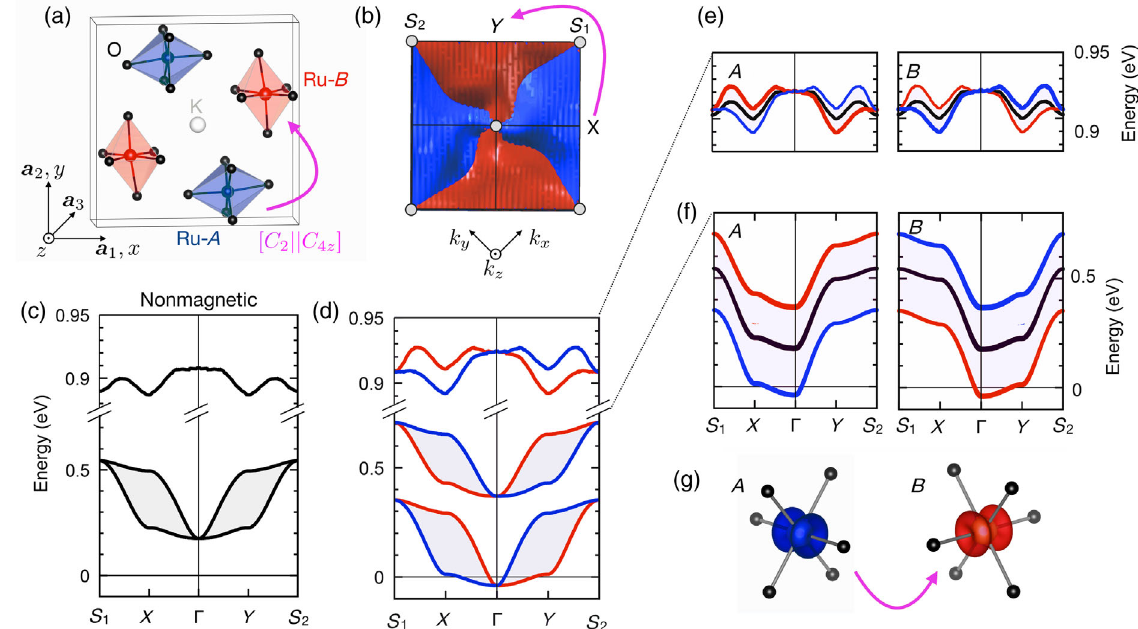
FIG. 3. Spin splitting by the electric crystal potential in KRu 4 O 8 in the third magnetic phase. (a) Schematic spin arrangement on the KRu 4 O 8 crystal with opposite-spin directions depicted by red and blue color. Magenta arrow and its label highlights the opposite-spin- sublattice transformation containing a real-space fourfold rotation. (b) Calculated spin-momentum locking with the characteristic spin- group integer 2 on top of two DFT Fermi surface sheets. (c),(d) DFT band structure of the nonmagnetic phase and the third magnetic phase, respectively. Gray shading highlights the k -dependent splitting by the anisotropic electric crystal potential. (e),(f) Projection of bands on the sublattices A and B in the nonmagnetic phase (black) and third magnetic phase (red and blue) for the upper bands and lower bands, respectively. Color shading in (f) highlights the nearly k -independent magnetic splitting of the lower bands, and its opposite sign for the sublattices A and B bands. (g) Real-space DFT spin density around the Ru atom in sublattices A and B